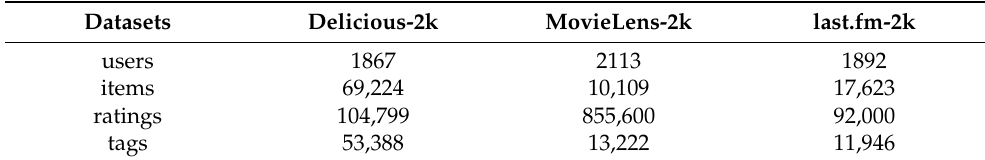
Table 5. Dataset